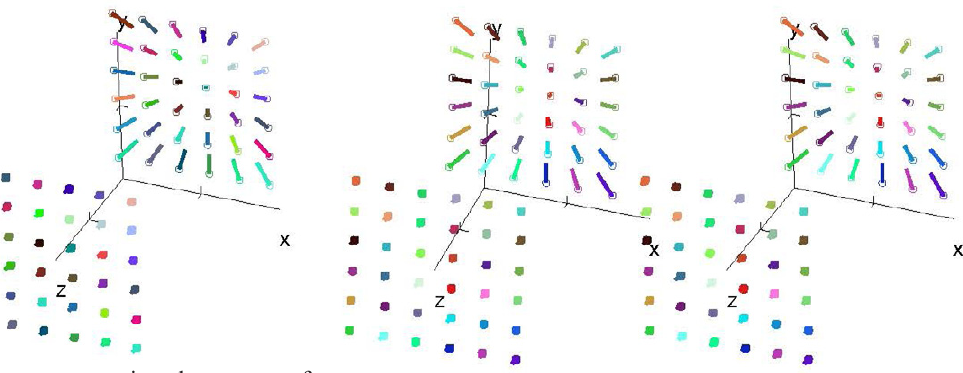
Figure 9. Stereo-pair scatter plot of the ray vectors traversing the cornea of Subject 4. Figure 10 . Stereo-pair scatter plot of the ray vectors traversing the cornea of Subject